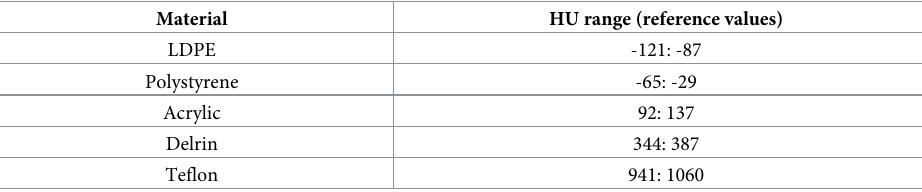
Table 2. Nominal HU values of the Catphan-CTP404 module inserts